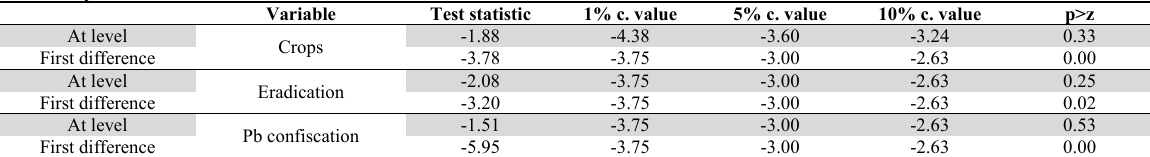
Stationary test